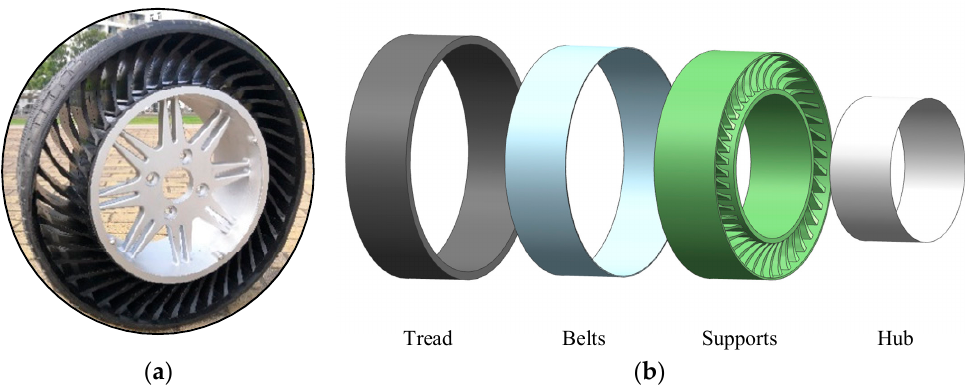
Figure 1. NPT: ( a ) Physical sample of NPT; ( b ) Composition structures of NPT.